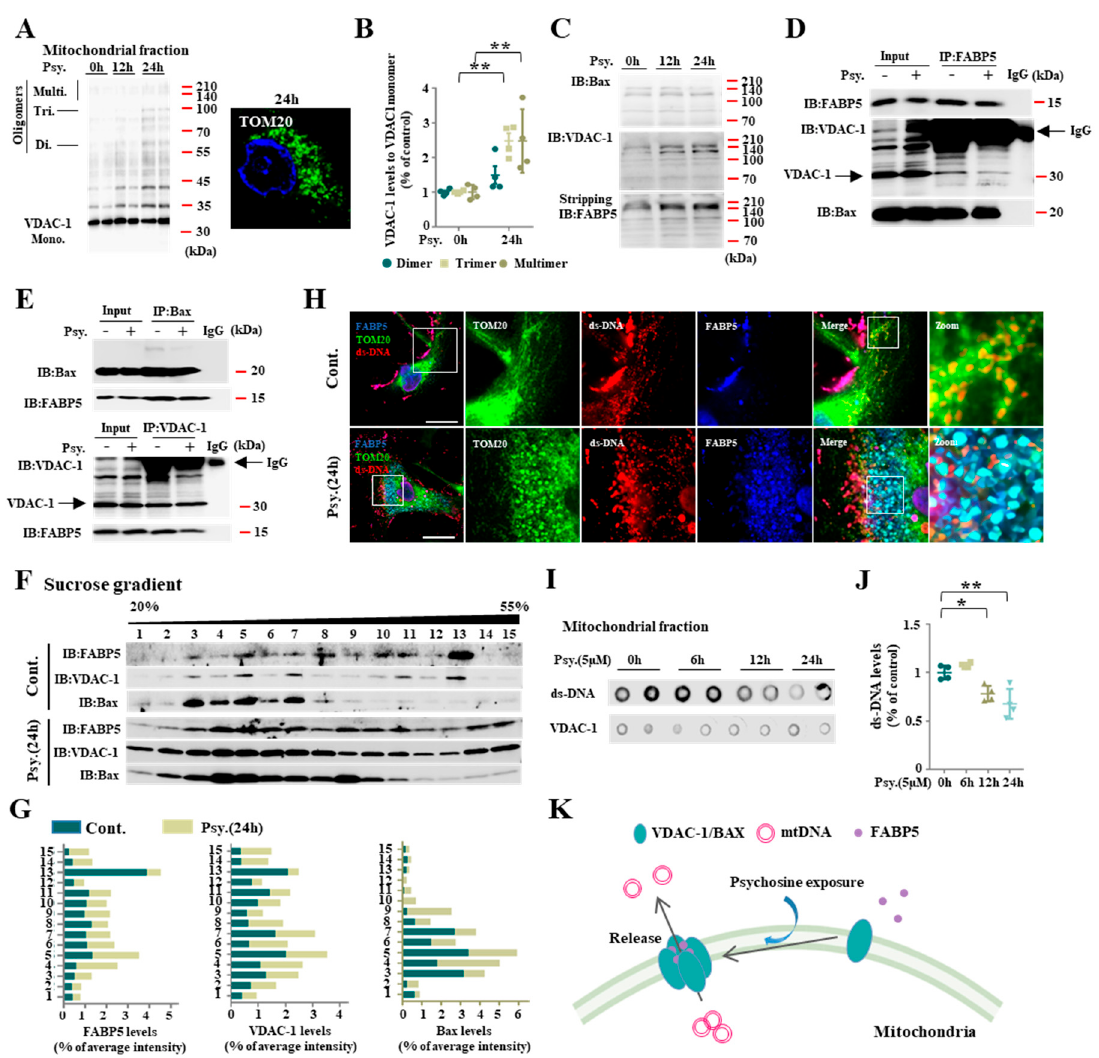
Figure 3. FABP5 facilitated mitochondria macropore formation following psychosine exposure. ( A ) Western blot analysis of VDAC-1 in mitochondrial fraction (left), showing that VDAC-1 dimers (60 kDa), trimers (about 100 kDa), multimers (above 140 kDa) appeared in psychosine-treated KG-1C cells. Confocal microscopy of TOM20 (green) and DAPI (blue) (right), showing mitochondrial loss after psychosine treatment. ( B ) Quantification of VDAC-1 levels, suggests an increase in VDAC-1 oligomers in psychosine-treated KG-1C cells ( n = 4). ( C ) Western blot analysis of BAX, VDAC-1 and FABP 5 in high molecular weight, showing potential e ff ects of FABP5 in VDAC-1 oligomerization. ( D , E ) Co-immunoprecipitation of FABP5, BAX and VDAC-1, suggests that FABP5 makes complexes with VDAC-1 and BAX. ( F ) Sucrose gradient assay of FABP5, VDAC-1 and BAX. Compared with control, in psychosine-treated cells, VDAC-1 and FABP5 shifted to more heavy sucrose fractions (14 and 15), however BAX only shifted a little to fractions 9 and 10. ( G ) Bar graph of ( F ). ( H ) Confocal microscopy of immunofluorescence staining of ds-DNA (red), TOM20 (green), FABP5 (blue), showing FABP5 shifted to mitochondria and mtDNA released to cytosol from mitochondria. ( I ) Dot blot of dsDNA in the mitochondrial fraction, showing decreased dsDNA in mitochondria after psychosine treatment. ( J ) Quantification of dsDNA in the mitochondrial fraction ( n = 4). ( K ) Schematic diagram of FABP5 participating in mitochondria pore formation under psychosine exposure. The data are shown as mean ± standard error of the mean and were obtained using a one-way analysis of variance. * p < 0.05 and ** p < 0.01. Psy, psychosine; IP, immunoprecipitation; IB, immunoblotting. Scale bar = 50 µ